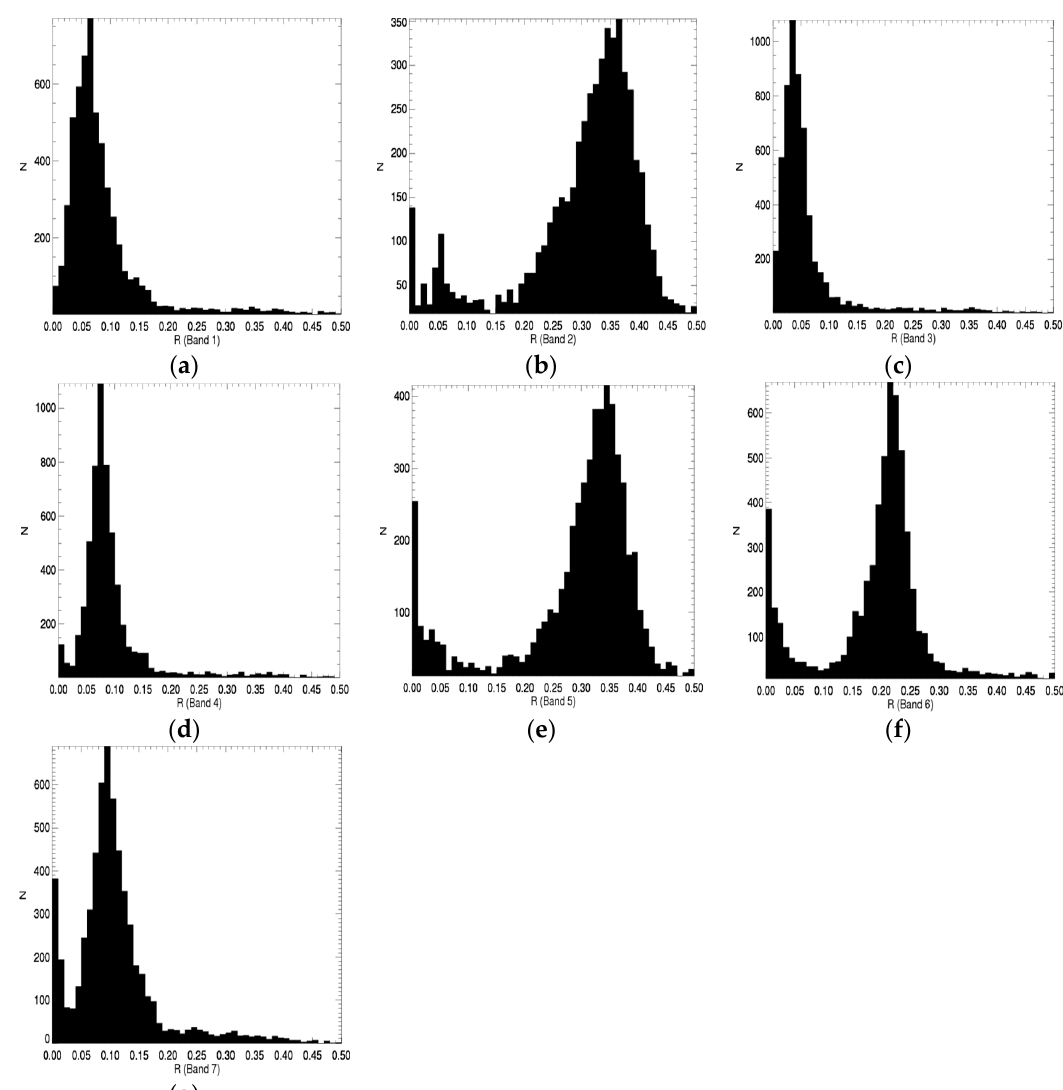
Figure 6. Surface reflectance histograms for MODIS bands ( a ) 1 to ( g ) 7 on 25 October 2015 around the Pampanga River basin, Philippines. Clear bimodal distributions appear in the histograms for bands 2, 5, and 6.